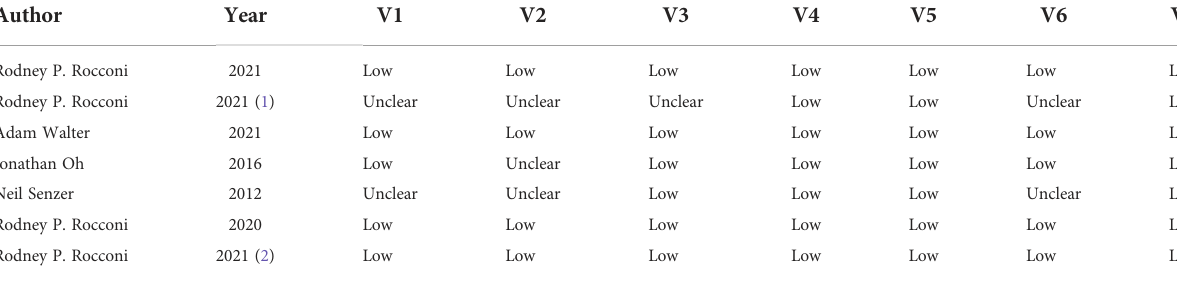
TABLE 2 Cochrane Collaboration ’ s tool for evaluation risk of bias in included studies.